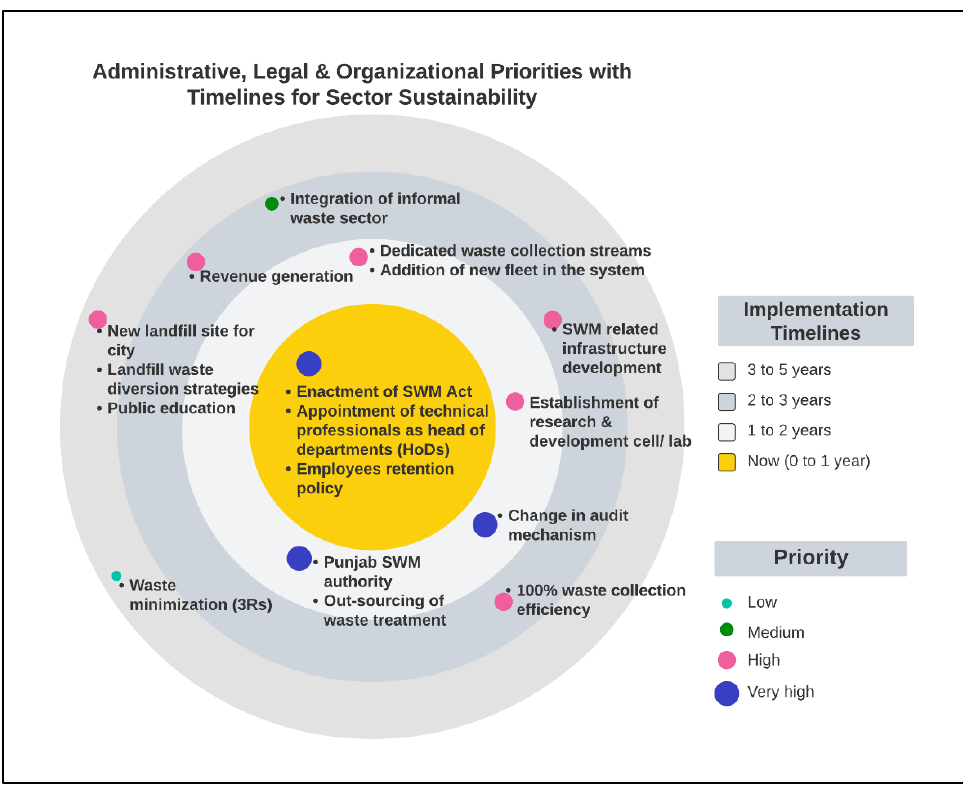
Figure 23. Priority areas for implementation of plans with timelines.